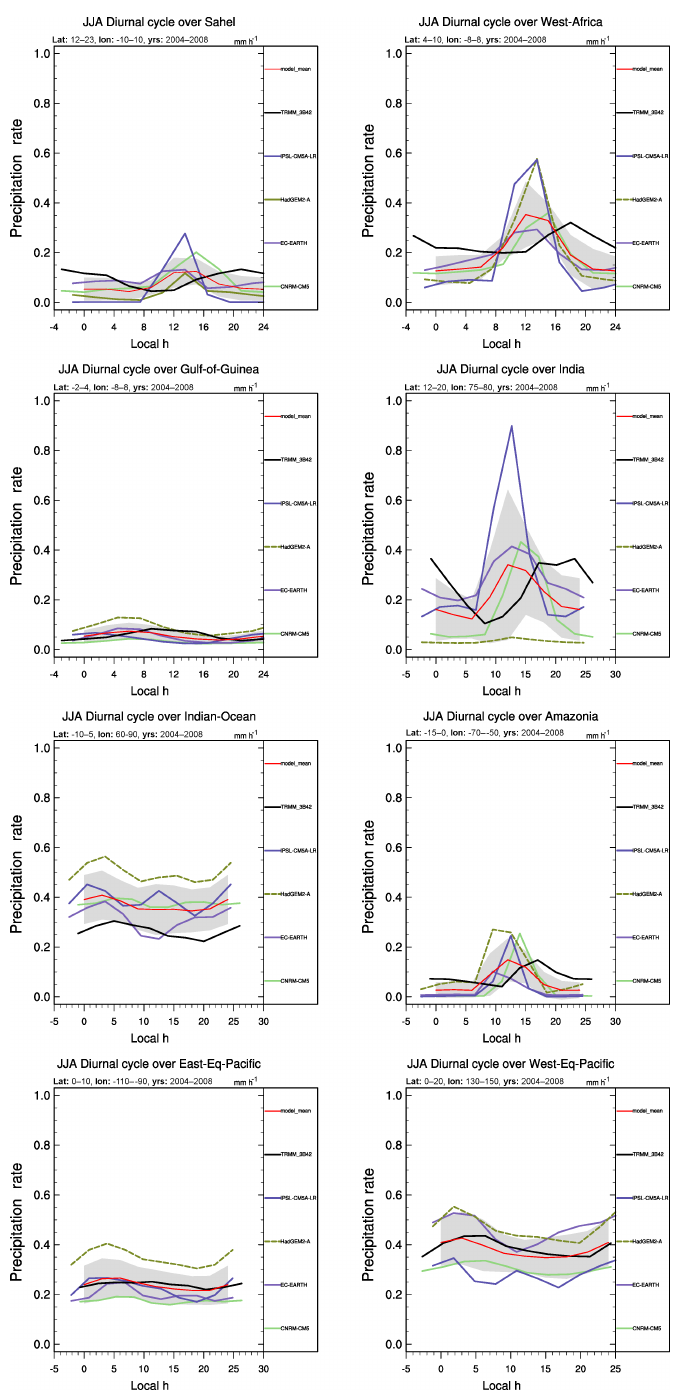
Figure 11. Mean diurnal cycle of precipitation (mmh − 1 ) averaged over five summers (2004–2008) over specific regions in the tropics (Sahel, West Africa, Gulf of Guinea, India, Indian Ocean, Amazonia, eastern equatorial Pacific, and western equatorial Pacific) as observed by TRMM 3B42 V7 and as simulated by four CMIP5 models: CNRM-CM5, EC-Earth, HadGEM2-A, and IPSL-CM5A-LR. ESMs produce a too strong peak of rainfall around noon over land, while the observed precipitation maximum is weaker and delayed to 18:00. At the same time, most models underestimate nocturnal precipitation. Over the ocean, the diurnal cycle of precipitation is more flat, but the rainfall maximum usually occurs a few hours earlier than in observations during the night, and the amplitude of oceanic precipitation shows large variations among models. Produced with namelist_DiurnalCycle_box_pr.xml